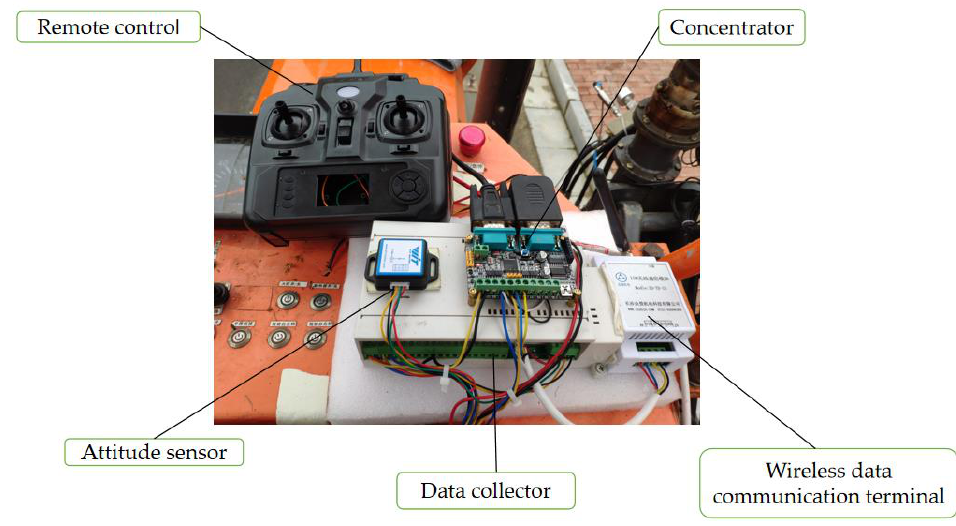
Figure 2. Onboard Figure 2. Onboard unit.